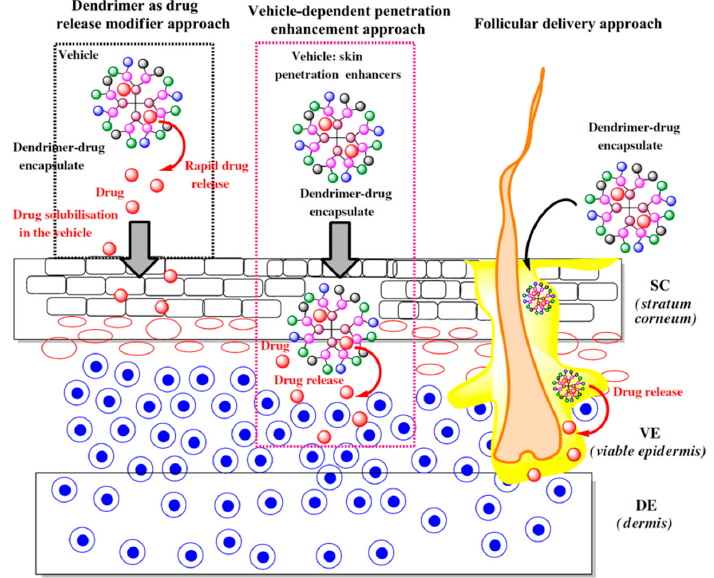
Figure 41. A systematic illustration of possible mechanisms; wherein, dendrimers may act as a release modifier to enhance skin absorption. When applying aqueous solutions of drug-loaded dendrimer to the skin, the solubilized form of the drug enables rapid release with high thermodynamic activity to boost drug permeation. Poor drug solubility in water limits dissolution, resulting in low drug activity and inefficient permeation. Adapted from [124] The Royal Society of Chemistry. Reprinted with permission from [126]. Copyright 2012 Elsevier.